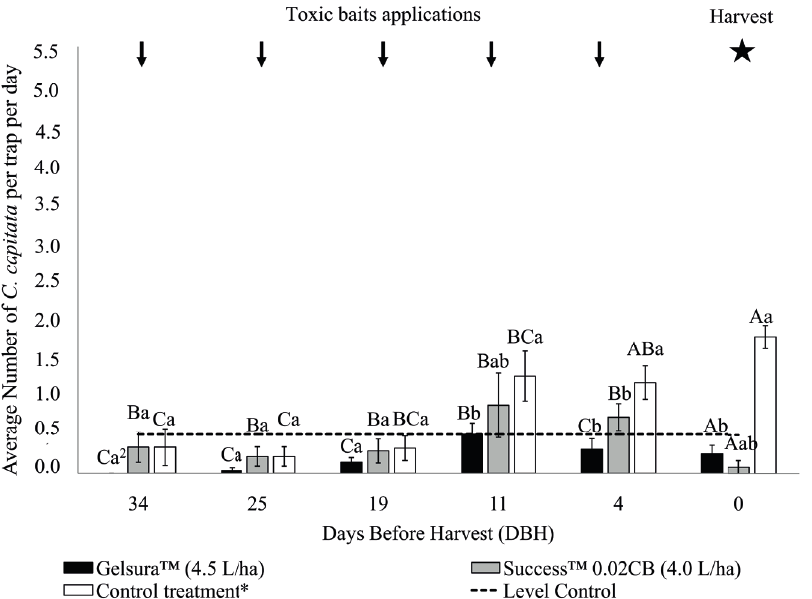
Figure 2 - Number of Ceratitis capitata captured in four Jackson traps on ‹Arra-15› grapevines during the six-week evaluation period in plots with Gelsura™ toxic baits (1:2 parts of water) and Success™ 0.02 CB (1:1.5 parts of water). Area 2: Petrolina, PE, October/November, 2017. 2 Number of fl ies per trap per day (FTD) followed by equal capital letters over the course of six weeks of evaluation and by the same lowercase letters within the evaluation week do not diff er (Tukey’s test at 5% probability of error). Dashed line indicates the level of control (0.5 FTD). *Control plot without the application of